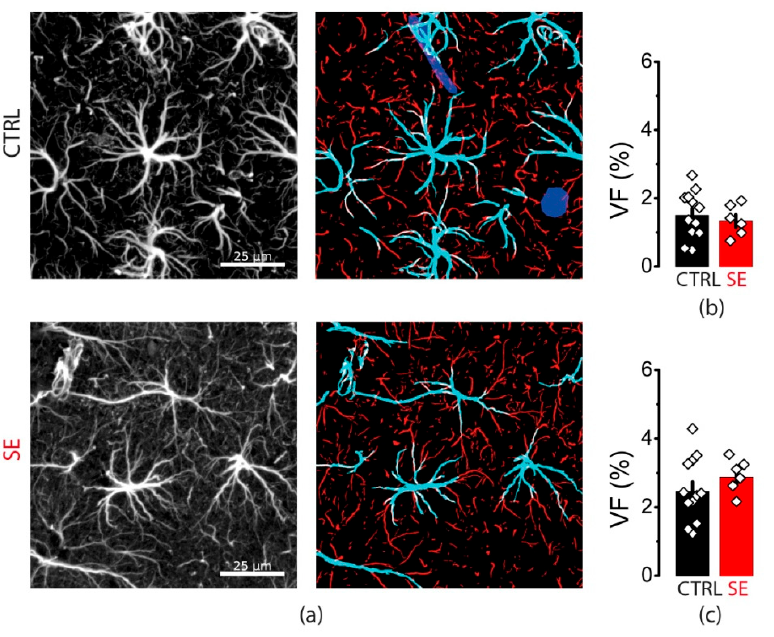
Figure 8. GFAP immunostaining. ( a ) Representative examples of GFAP immunostaining from the dorsal hippocampus of control (CTRL) and experimental (SE) groups. Left: maximal projection of GFAP-stained stack. Right: segmentation to thick (cyan) and thin (red) GFAP-positive processes. Volume fractions (VF) of thick ( b ) and thin ( c ) astrocyte processes. Data presented as mean ± SEM. Each rhombus represents a value obtained in an individual animal. T -tests, p > 0.05.